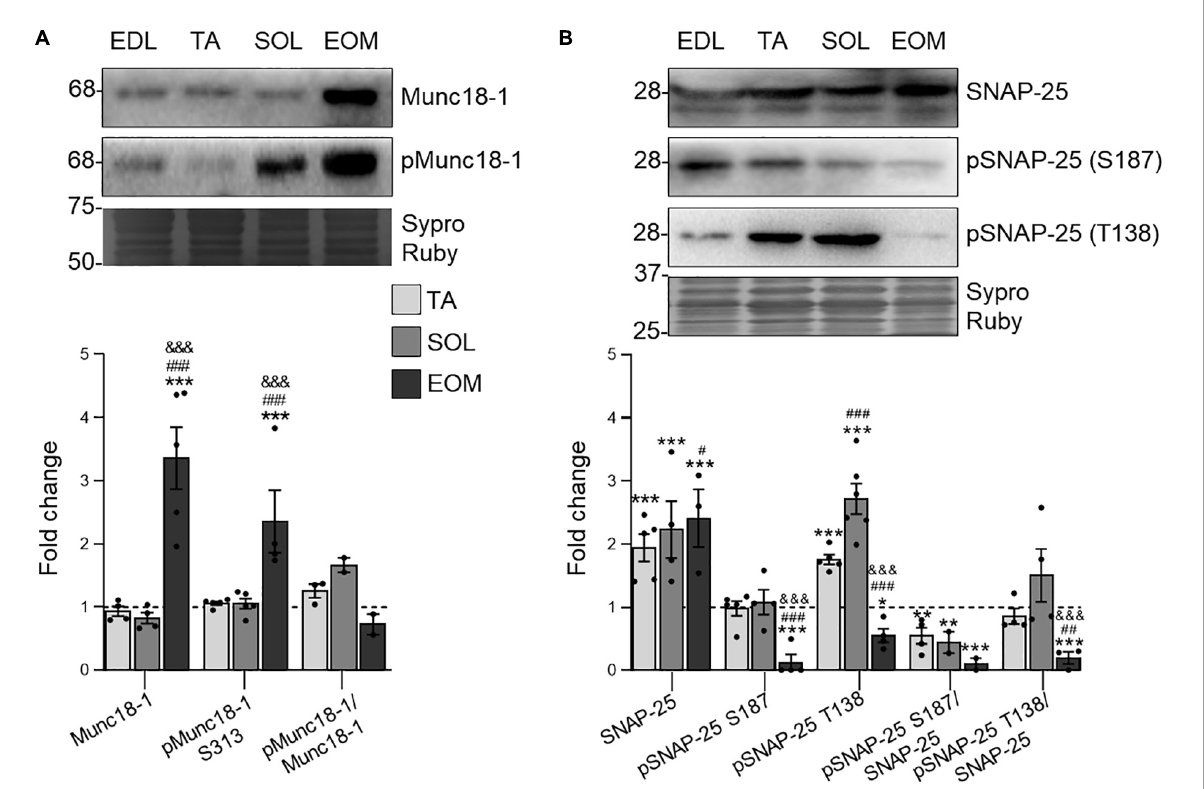
FIGURE5 The SNARE/SM Munc18-1 and SNAP-25 expression changes in EDL, TA, SOL, and EOM of Sprague Dawley rats. Western blot analysis and data quantification of (A) Munc18-1 and (B) SNAP-25 protein levels in different muscles. Sypro Ruby images show the region surrounding each protein of interest despite the bands’ optical densities being normalized using the full length of the lanes. Data are presented as mean ± SEM. Each circle in the bars is the mean result of one animal. * P ≤ 0.05; ** P ≤ 0.01; *** P ≤ 0.001; *against EDL, # against TA, & against SOL (Kruskal–Wallis test and Dunn’s post-hoc test). EDL, Extensor Digitorum Longus; TA, Tibialis Anterior; SOL, Soleus; EOM, Extraocular Muscles. Graphs done with GraphPad Prism software, San Diego,